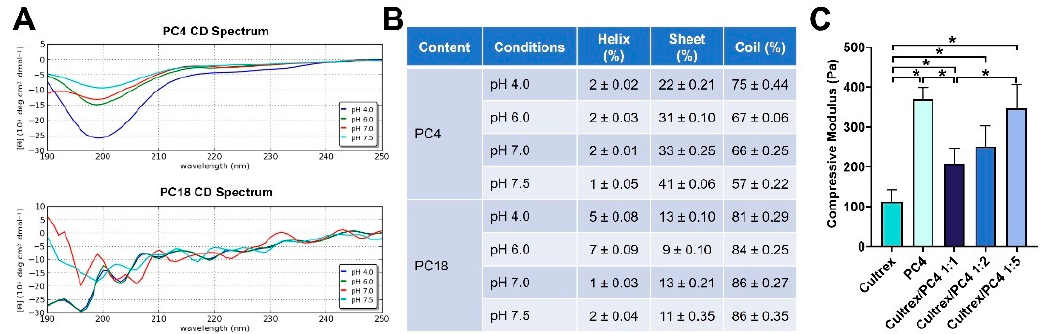
Figure 2. Characterization of PC peptides. ( A ) Circular Dichroism (CD) spectra of 50 µM PC4 and PC18 in 50 mM phosphate buffer at pH 4.0 to 7.5. The peptide was dissolved at room temperature and spectra were recorded at different pH conditions. ( B ) Determination of secondary structure content of PC peptides using CAPITO online CD spectrum analysis. The values are mean ± SD, calculated from triplicate measurements. ( C ) Compressive moduli of PC hydrogels prepared at different combinations. Data are given as mean ± SD; * p < 0.05.